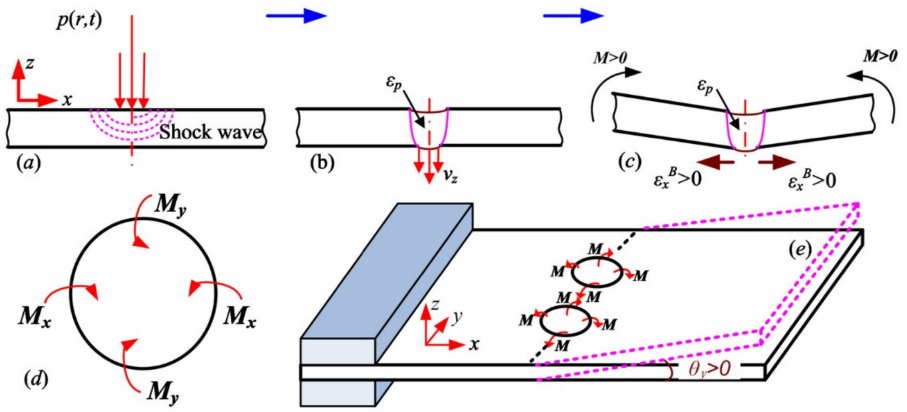
Figure 7. The shock bending mechanism (SBM) of LSF: ( a ) LSP loading; ( b ) downward movement and plastic deformation; ( c ) shocked bending; ( d ) bending moment on the cell and ( e ) bending of metal sheet with one end fixed